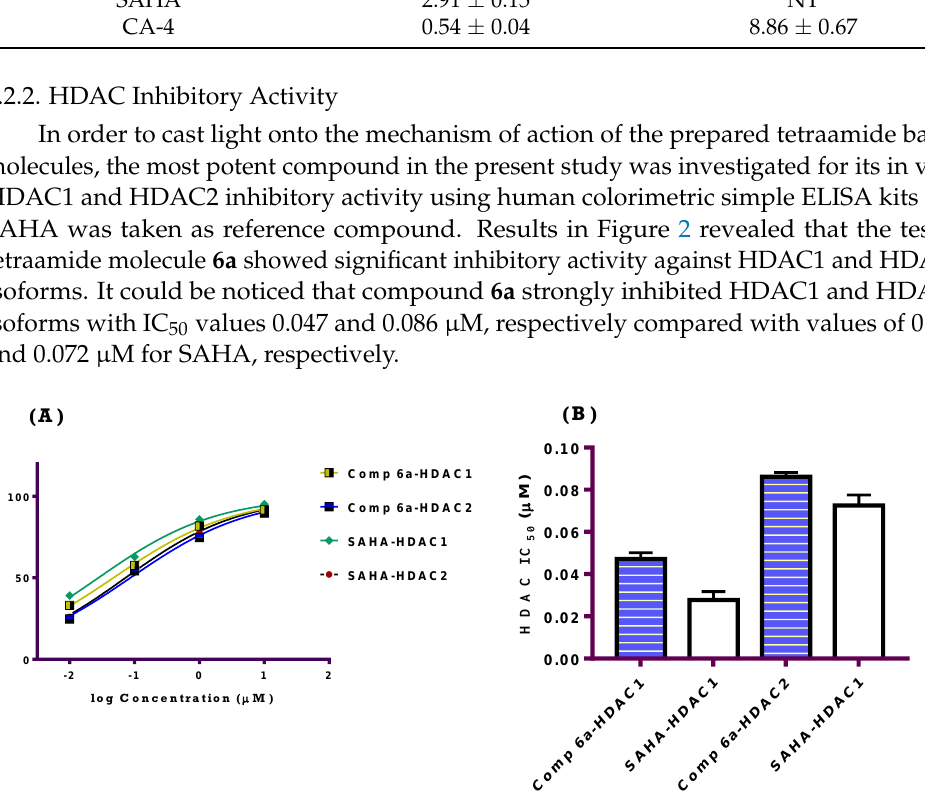
Figure 2. ( A ) Dose response curve for in vitro HDAC inhibitory activity of tetraamide 6a and SAHA against HDAC1 and HDAC2 isoforms. ( B ) Graphical representation for in vitro HDAC inhibitory activity of tetraamide 6a and SAHA against HDAC1 and HDAC2 isoforms .